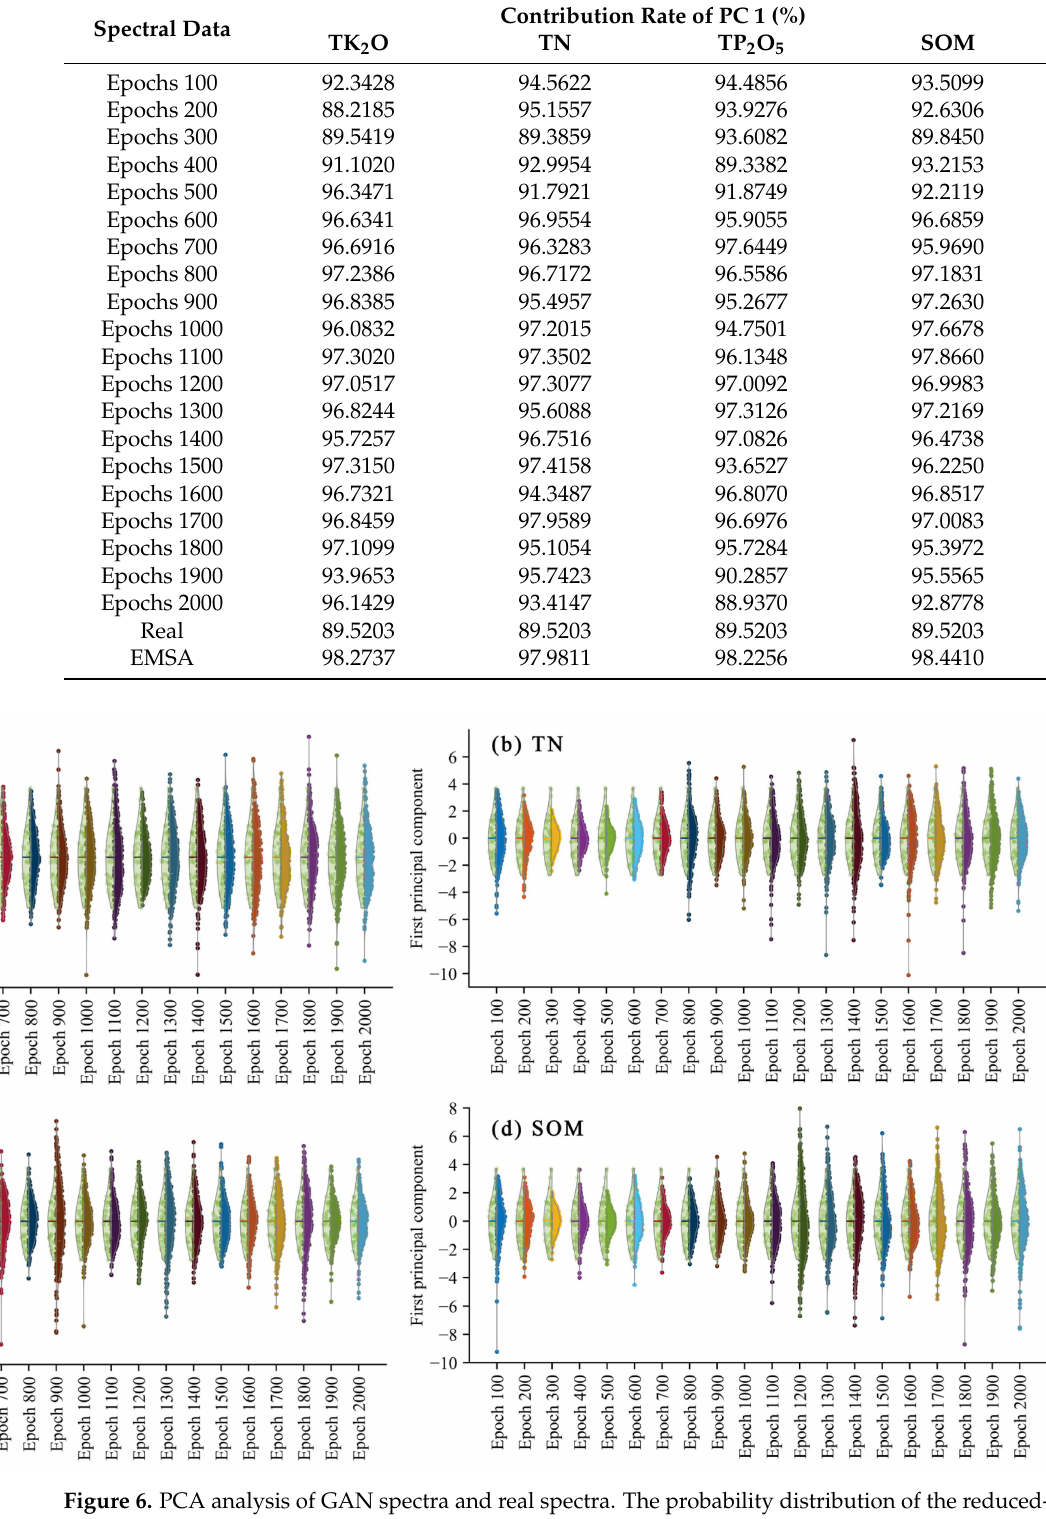
Table 2. The contribution rate of the first principal component corresponding to the generated and the real spectra data.